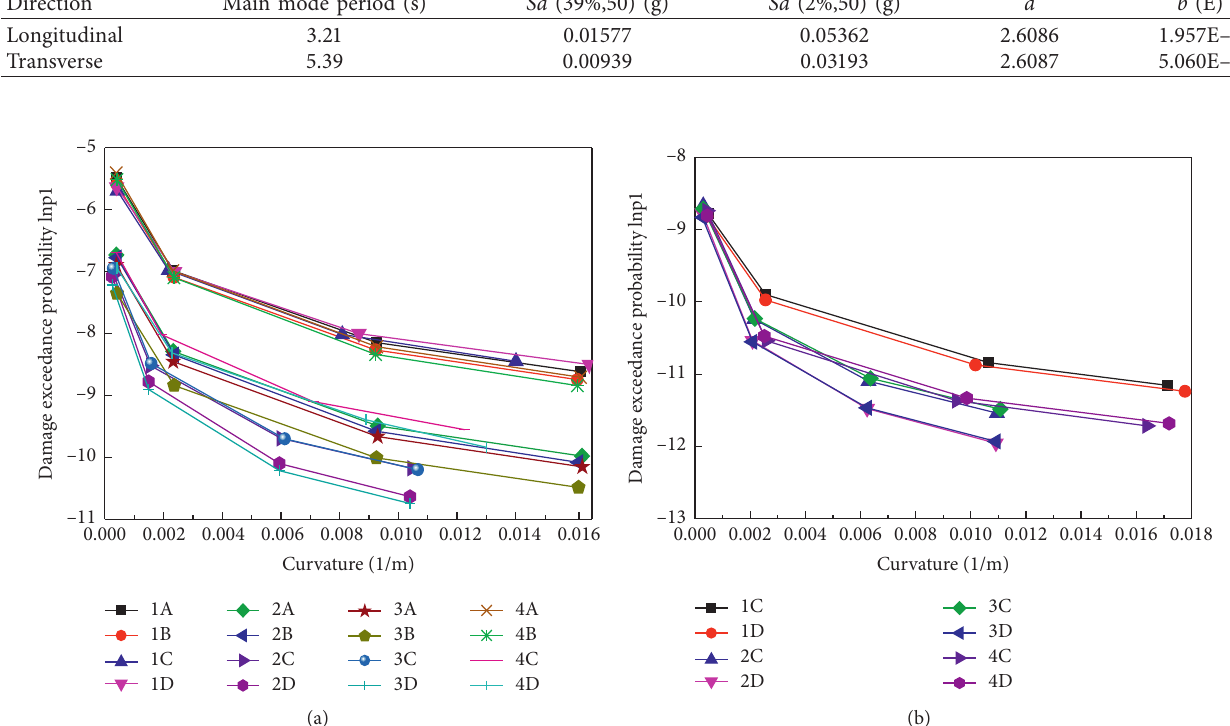
Figure 10: Probability curve of seismic damage risk in design reference period. (a) Longitudinal. (b)